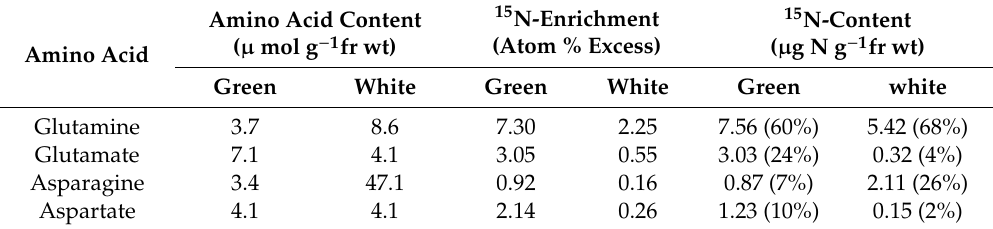
Table 3. Assimilation of 1 mM 15 NO 2 − by 60-min incubation to amino acids in the green and white leaf segments from 15-day-old albino mutant rice plants in